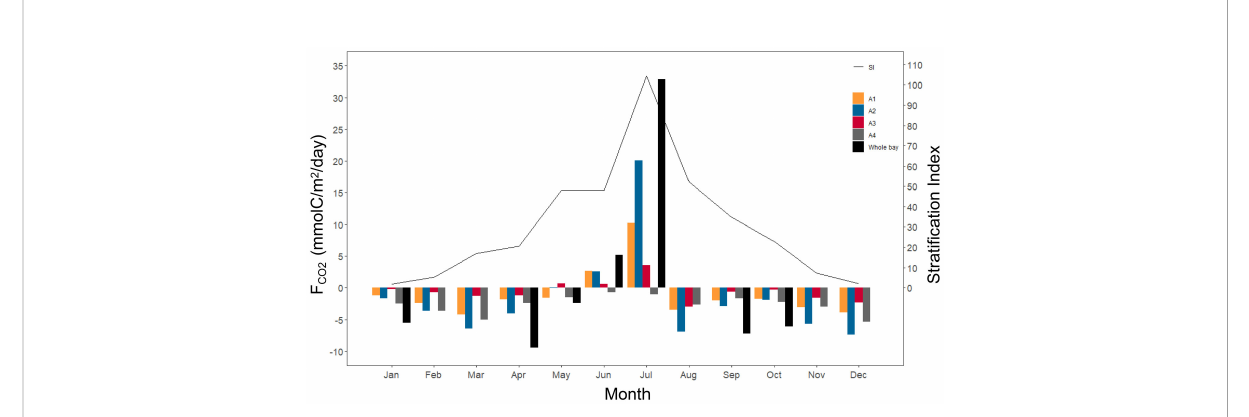
FIGURE 8 Monthly air – water CO 2 fl uxes for the four areas and the whole bay (A1 to A4, Whole bay), and the strati fi cation index of the Yatsushiro